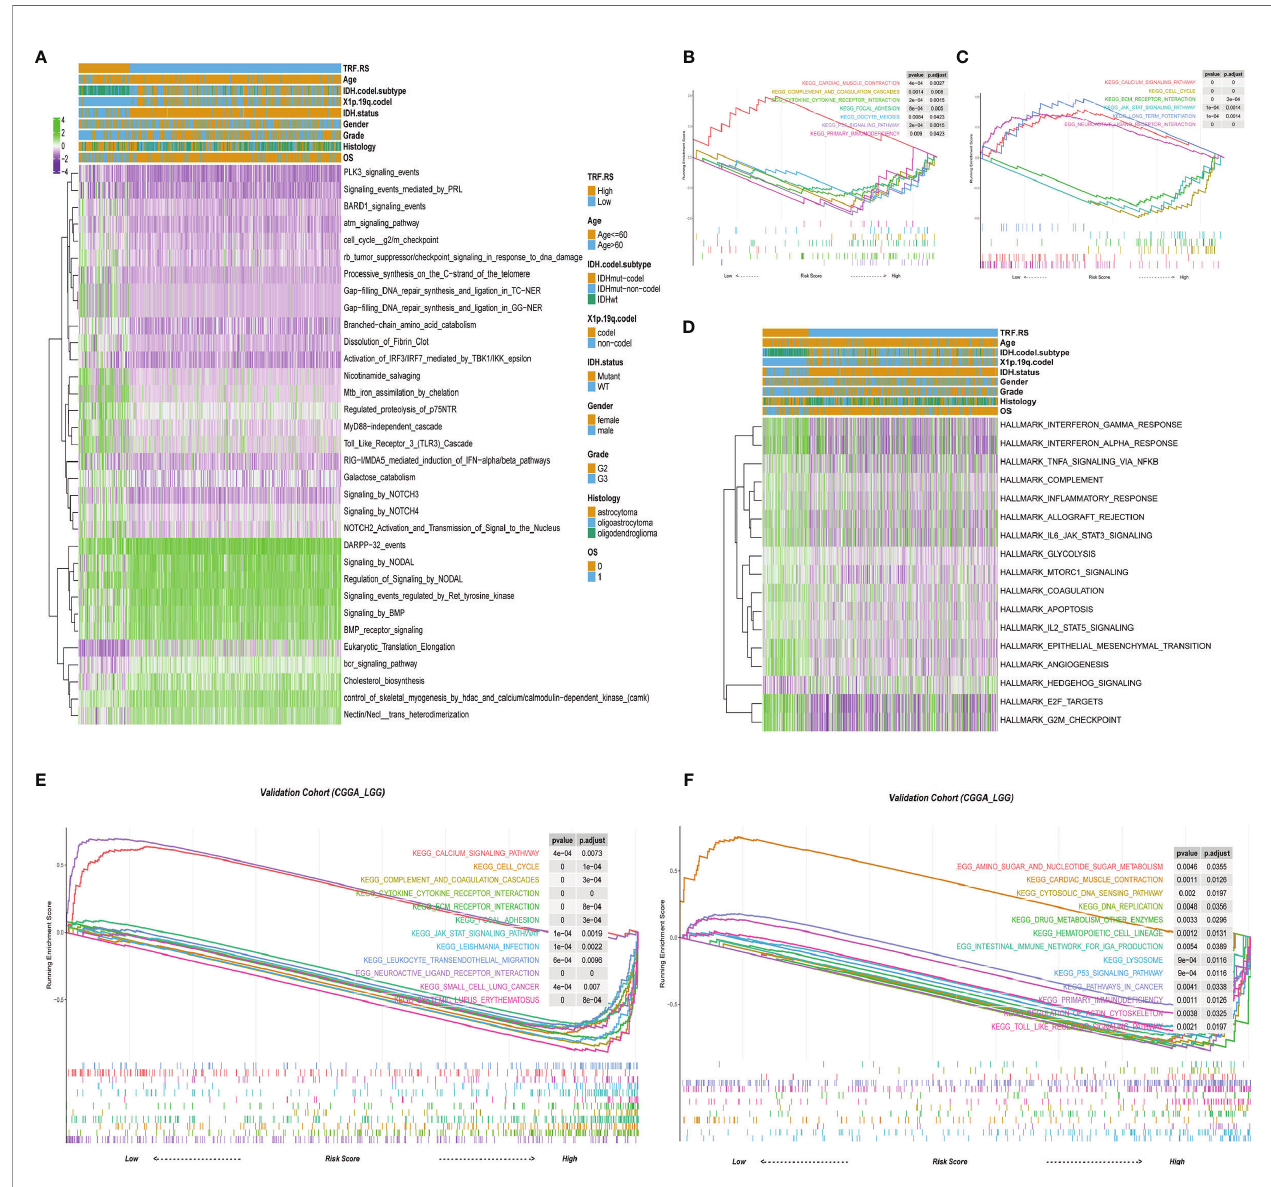
FIGURE 4 | The biology function enrichment analysis between the low- and high-risk score groups. (A) Gene Set Variation Analysis (GSVA) results based on the REACTOME gene sets. (B, C) Gene Set Enrichment Analysis (GSEA) results based on the Kyoto Encyclopedia of Genes and Genomes (KEGG) gene sets. (D) GSVA results based on the hallmark gene sets. (E, F) GSEA results based on the KEGG gene sets in the validation cohort